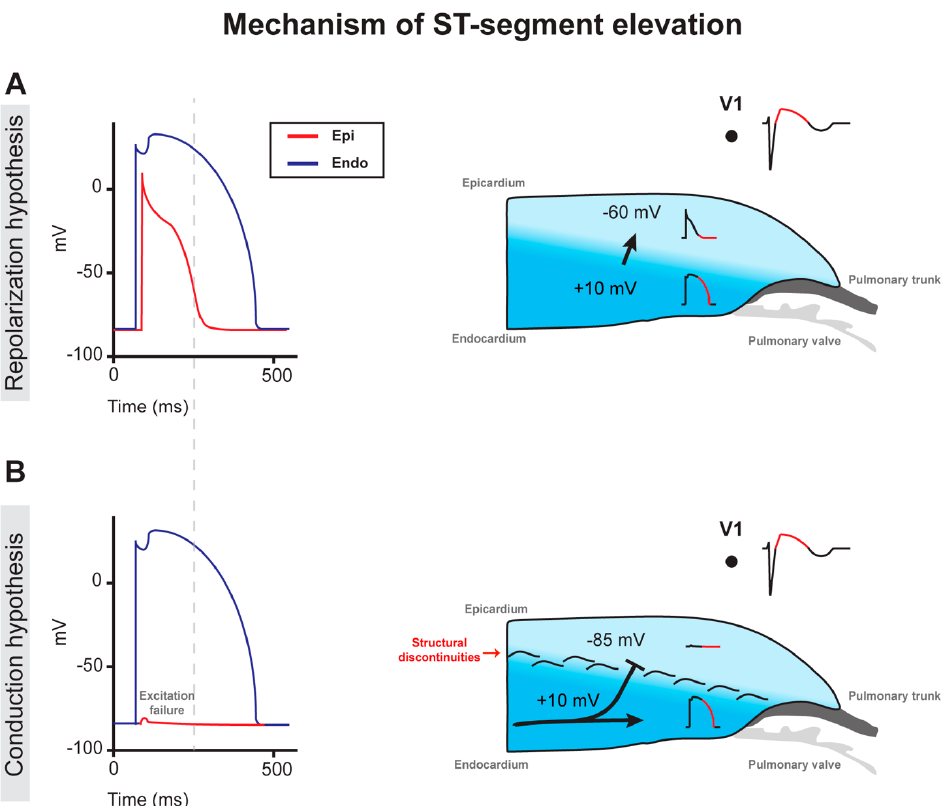
Figure 3. Mechanism of the ST-segment elevation in Brugada syndrome as postulated by the repolarization and conduction hypotheses. Action potentials from the subendocardial and subepicardial myocytes are indicated in blue and red respectively. ( A ) Transmural dispersion of repolarization, characterized by a loss of action potential dome in RVOT subepicardial myocytes, is caused by a reduced sodium current ( I Na ) in combination with strong intrinsic expression of the transient outward current ( I to ). ( B ) An abnormal pathway of conduction, imposed by subtle structural abnormalities throughout the RVOT myocardium, causes a current-to-load mismatch and conduction block which, in turn, leads to excitation failure of subepicardial myocytes.